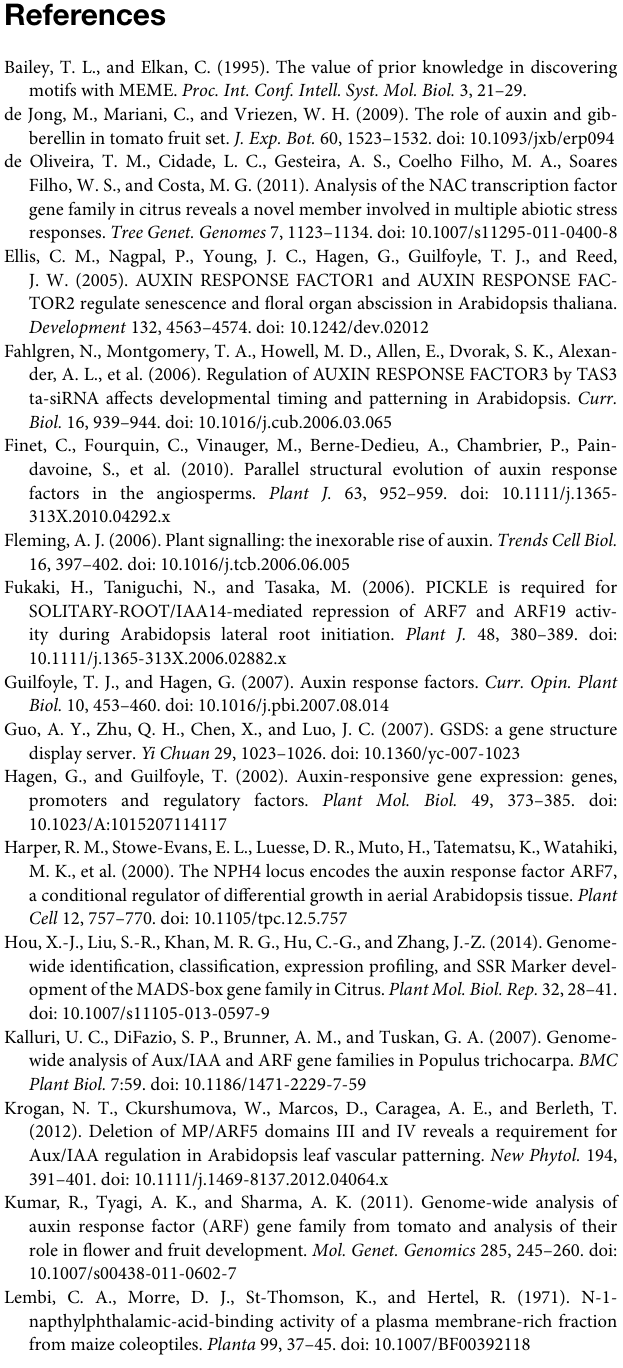
motifs are indicated by different colors. The length of motif in each promoter represents the actual length, and motif sizes are indicated at the bottom of the figure. Figure S4 | The expression of CiARF genes in response to 100 µ M IAA and NPA treatment, respectively. Real-time PCR was used to assess accumulation of CiARF genes at 0, 6, and 12h after treatment. Relative transcript levels are calculated by real-time PCR with β - actin as a standard. Data are means ± SE of three separate